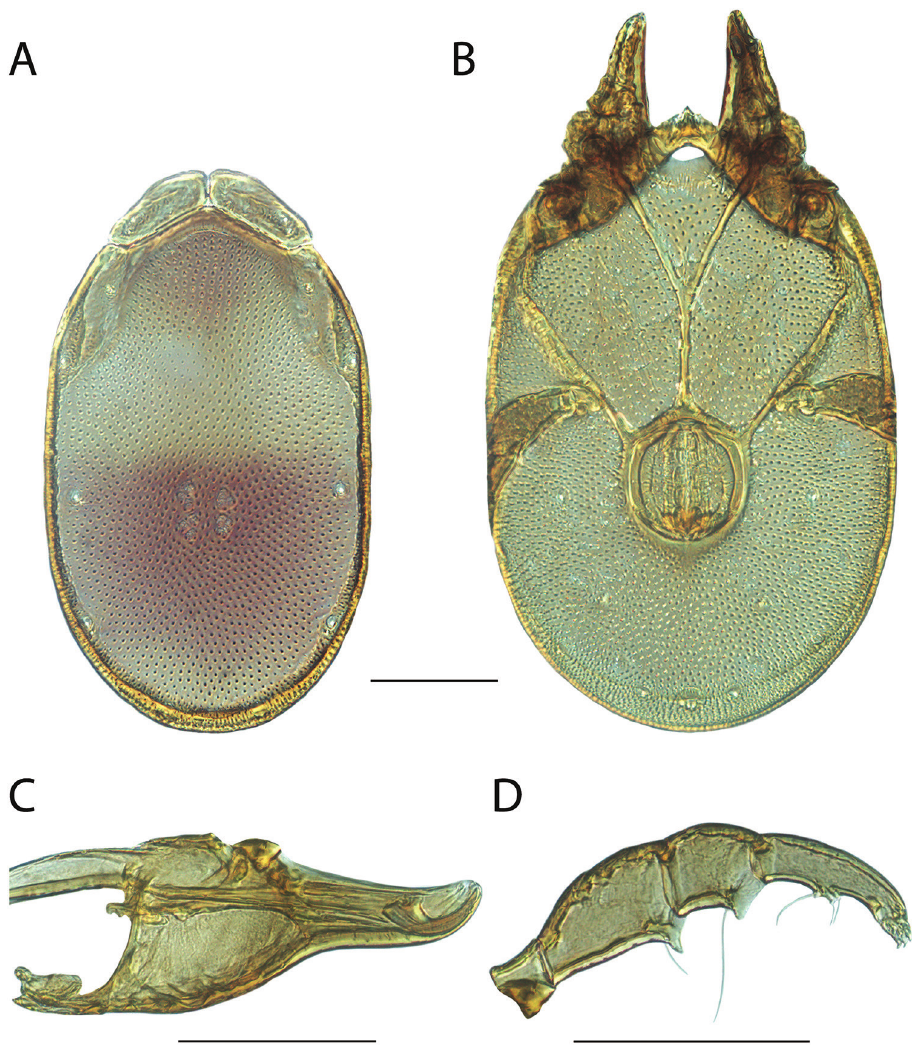
Figure 145. Torrenticola microbiscutella sp. n. male: A dorsal plates B venter (legs removed) C subcapitulum D pedipalp (setae not accurately depicted). Scale = 100